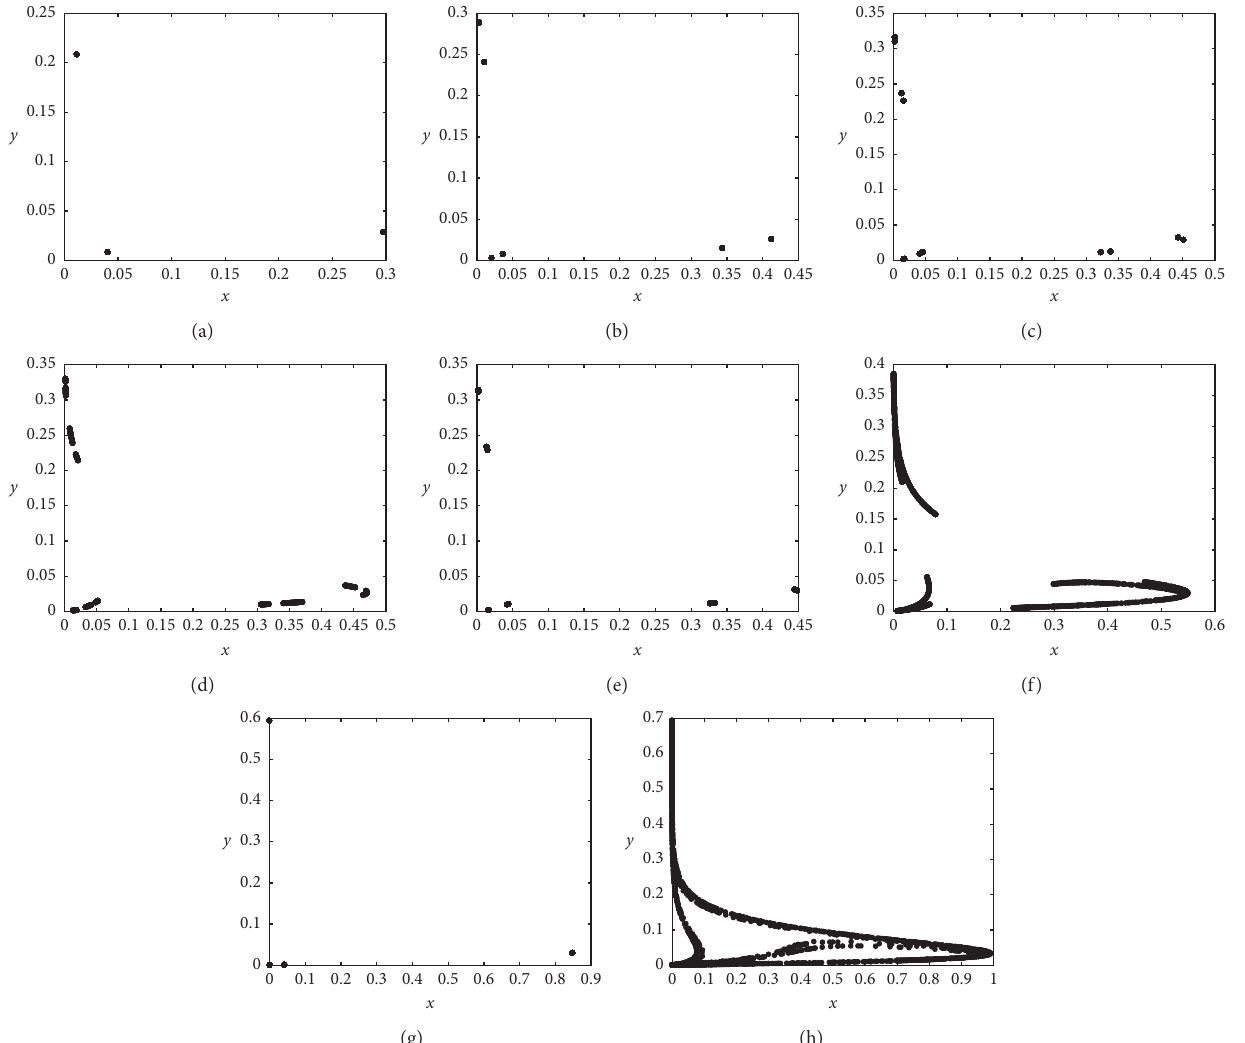
Figure 3: The phase diagrams of equation (3) ((a) 15.8 < a < 24, (b) 22.4 < a < 27, (c) a � 27.4, (d–f) 28.26 < a < 30.8, and (g-h) 30.8 < a < 60).